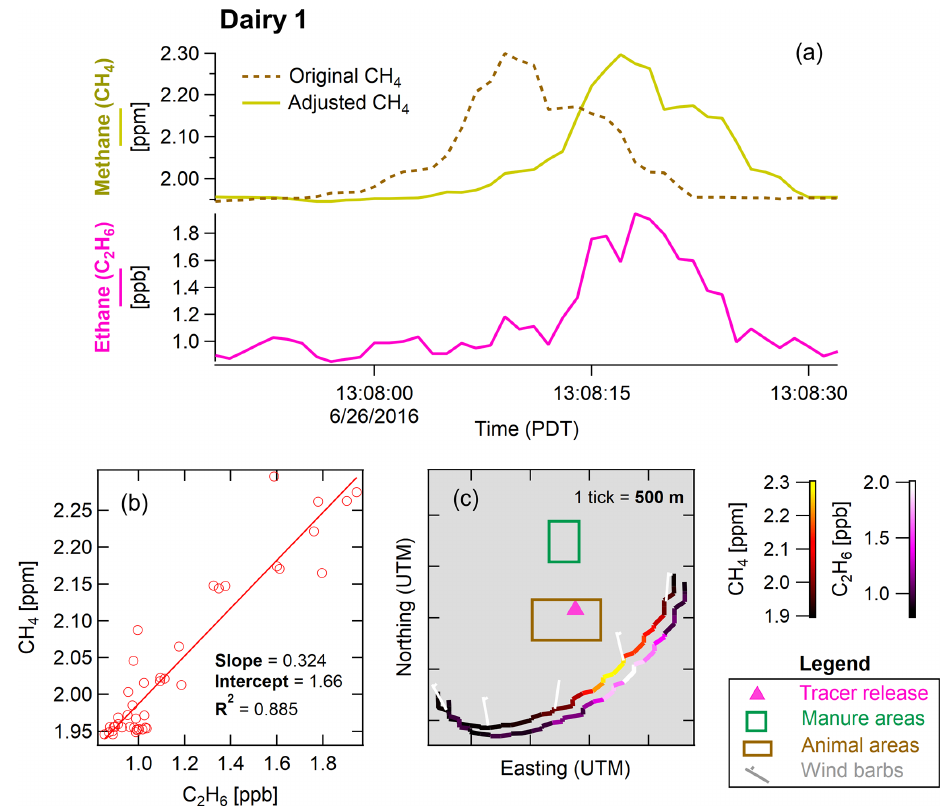
Figure 2. Time traces of methane (CH 4 ) and ethane (C 2 H 6 ) during a flight around Dairy 1 (a) . A correlation plot with a best-fit line (b) compares enhancements above baseline of CH 4 and C 2 H 6 after accounting for differences in instrument response times and tracer position relative to site emissions. See text for discussion of alternate analysis by area ratios. A map of Dairy 1 overlaid with the flight path is colored by CH 4 concentration (c) . An identical transect colored by C 2 H 6 is offset slightly for clarity. Wind barbs depict the wind velocity (averaging 2.4ms − 1 from NNW) at several points during the